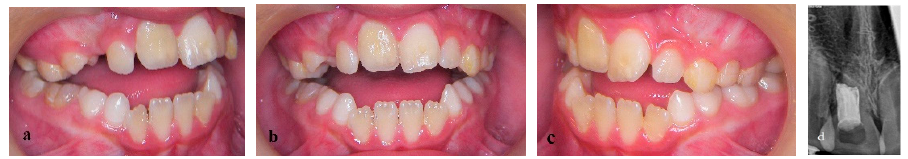
Figure 2. Initial photographs before orthodontic treatment. ( a – c ) Patient presented a severe open bite, ( d ) periapical radiograph on which root resorption of 11 is evident.